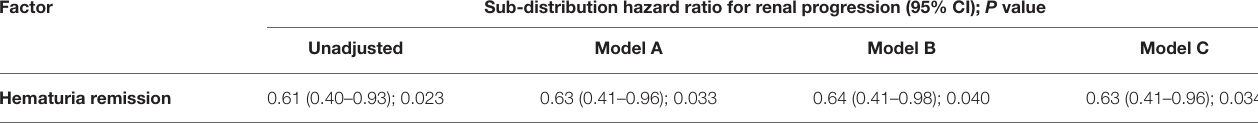
TABLE 5 | Hematuria remission and risk of renal